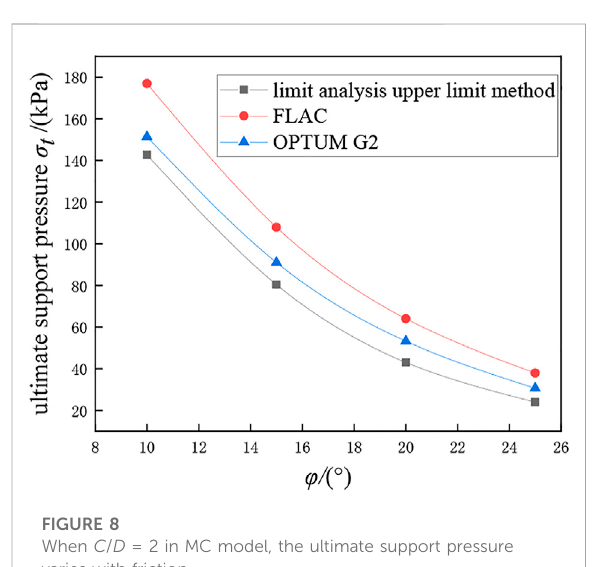
When C / D = 2 in MC model, the ultimate support pressure varies with friction.